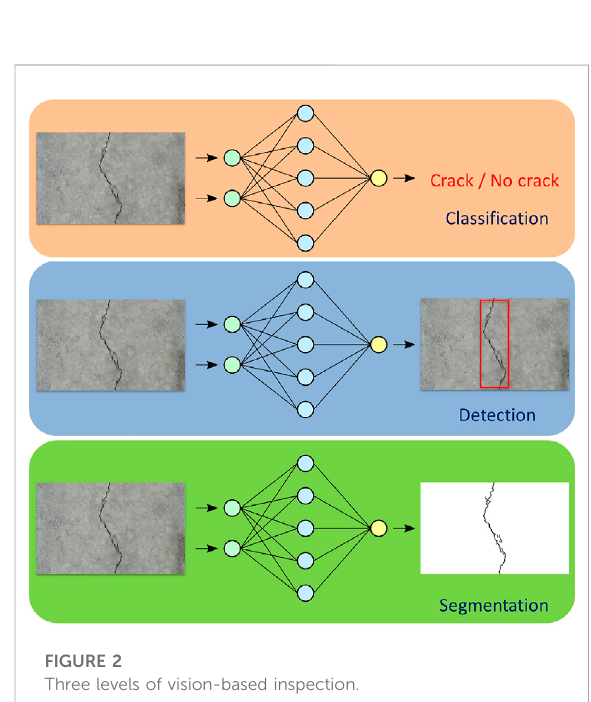
FIGURE 2 Three levels of vision-based